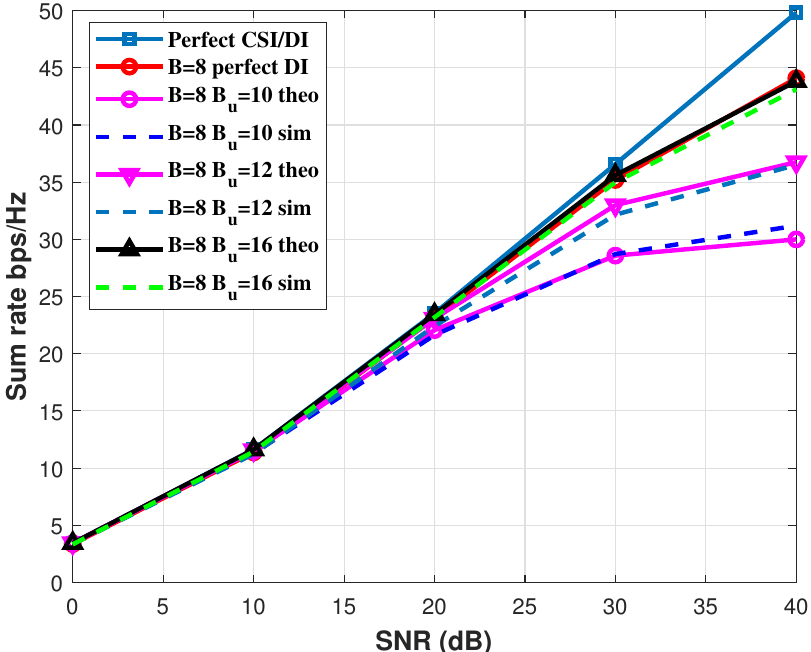
Figure 12. Performance comparison of theoretical and simulation results with SQ-based CSI feedback and RVQ-based DI feedback with different quantization bits in ( 3 × 2,1 )